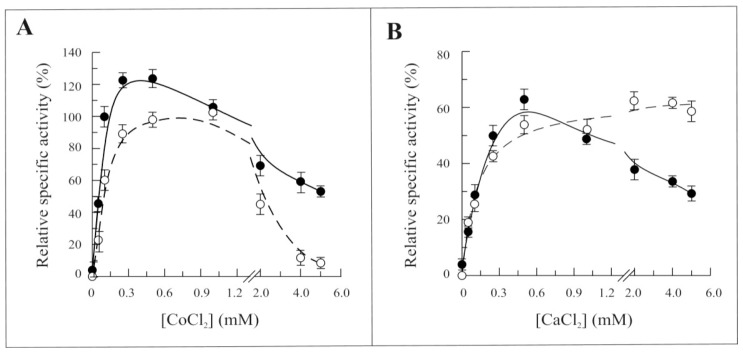
Dependence of the 6-His-Δ1-328-hFADS activity on CoCl2 and CaCl2 concentrations. The ability of 6-His-Δ1-328-hFADS (●, 0.32 nmol) and 6-His-hFADS2 (○, 0.17 nmol) to synthesize FAD is plotted as a function of CoCl2 (A) or CaCl2 (B) concentrations in the presence of 100 μM ATP and 2 μM FMN and in the absence of MgCl2 in the same experimental condition described in Figure 4A. Data are normalized to the maximum activity measured with 5 mM MgCl2 for each protein (arbitrarily set equal to 100%).